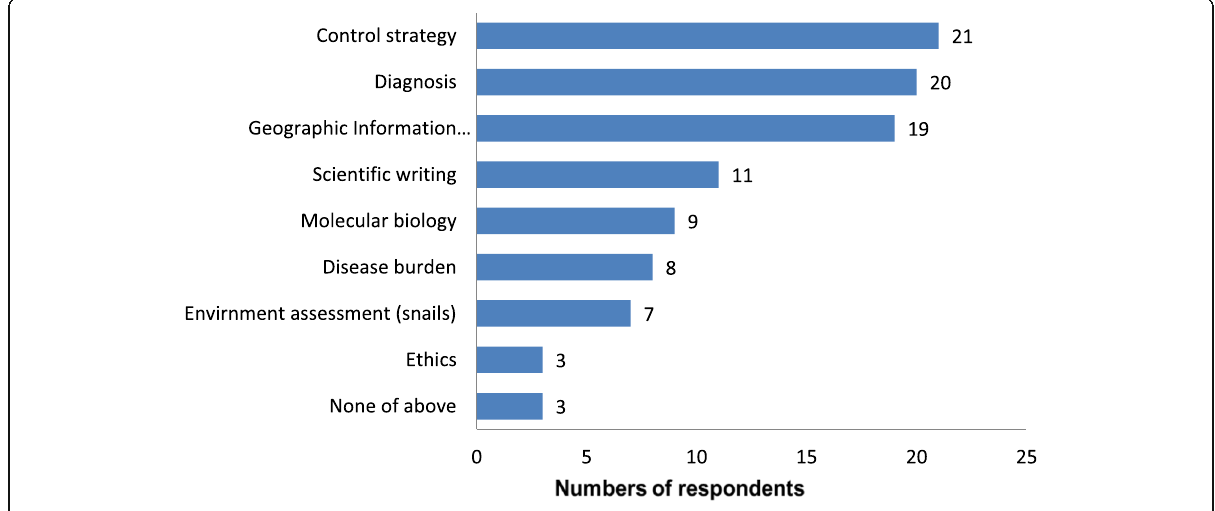
Fig. 2 Skills learned from training activities held in China by survey